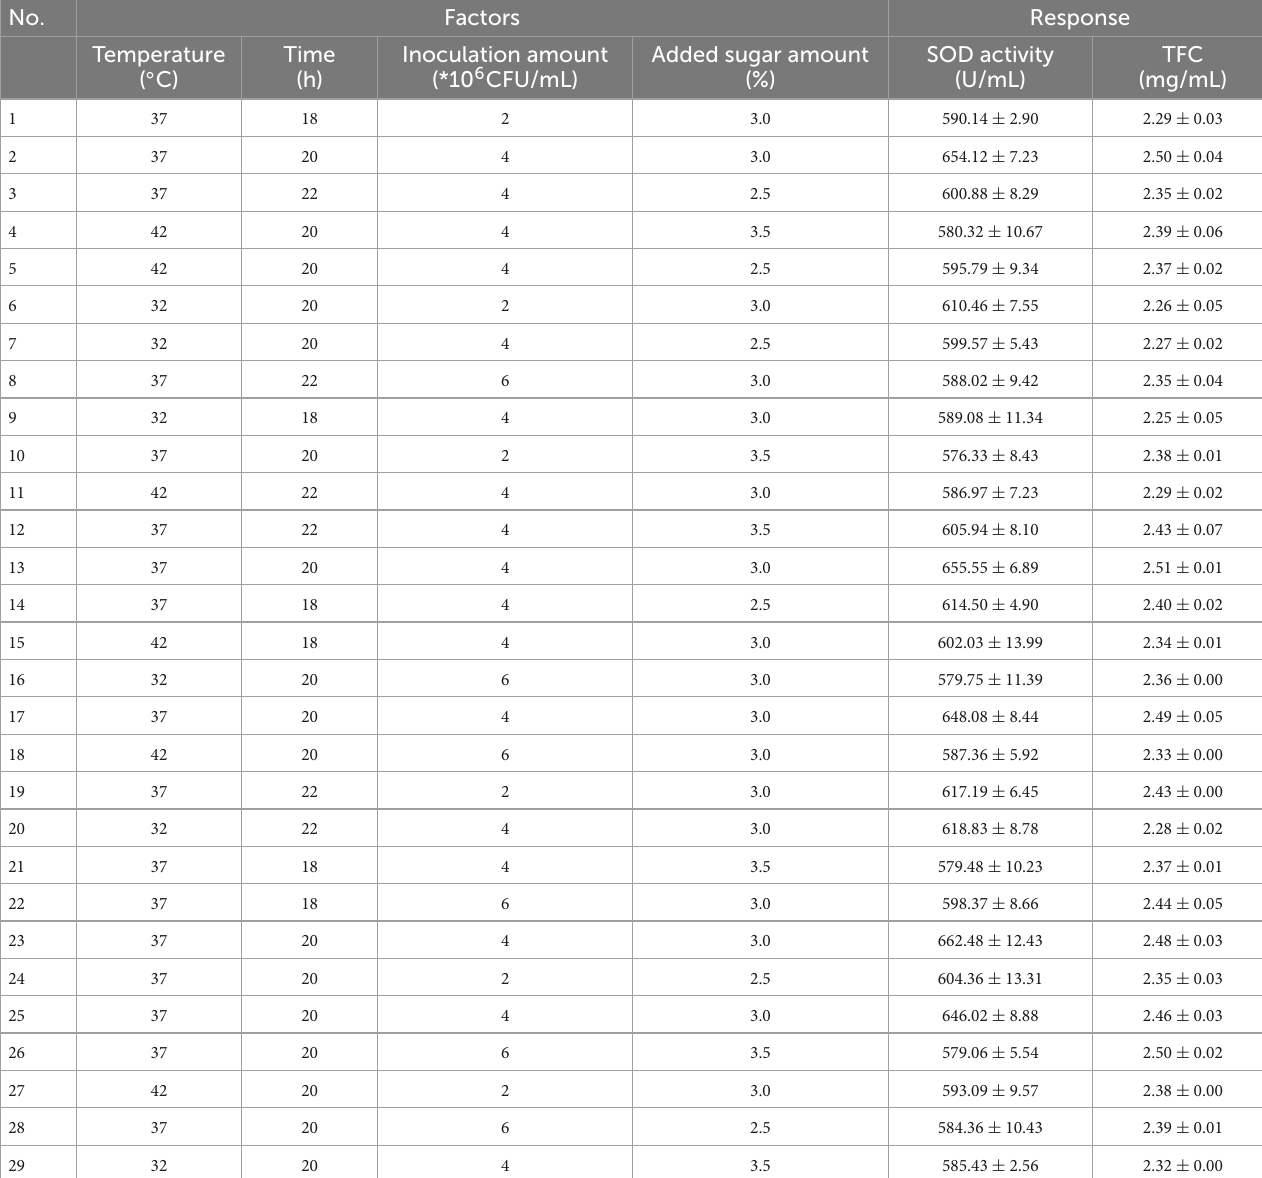
TABLE 3 The experiments and results of RSM for the SBJ fermentation process.